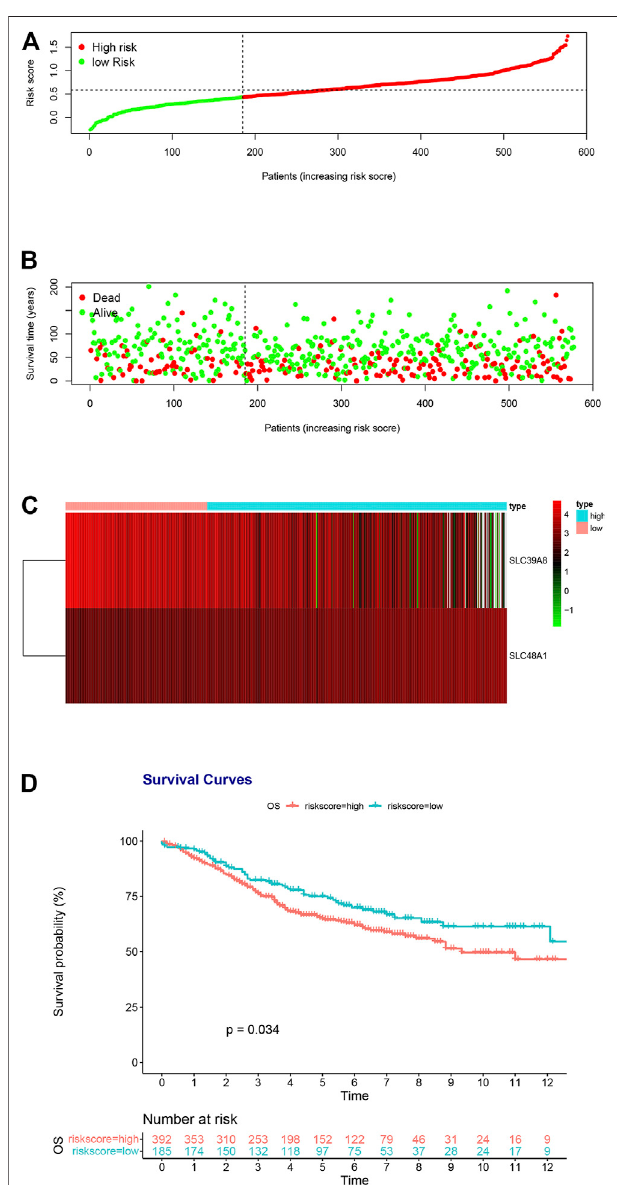
FIGURE 4 | Risk score analysis of the two-gene prognostic model in the GSE39582 validation cohort. (A) Survival differences between high- and low-risk groups. (B) Dot plots comparing outcomes of subjects in the high- and low-risk groups. (C) Heat map for gene expressions in the high- and low-risk groups. (D) Kaplan Meier survival analysis of all patients with COAD in the high- and low-risk groups.